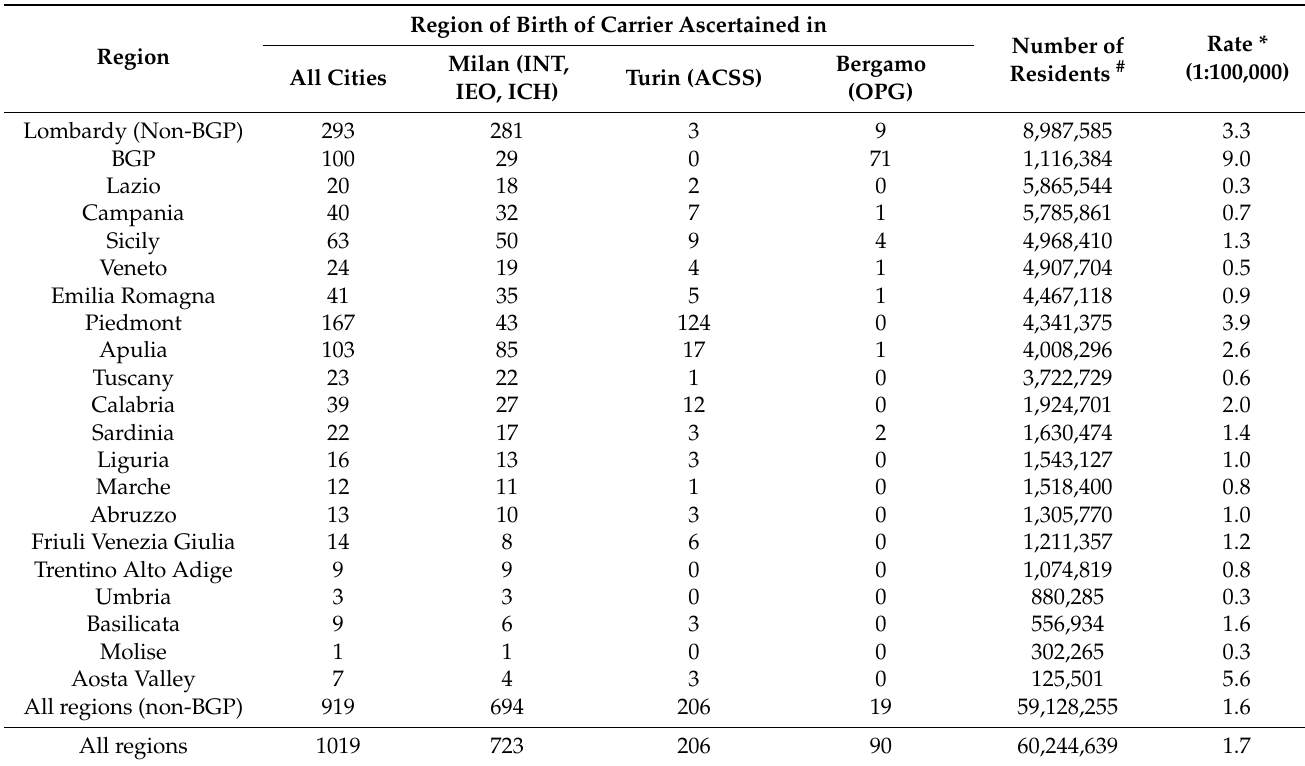
Table 4. Analysis of the BRCA1/2 PV carriers’